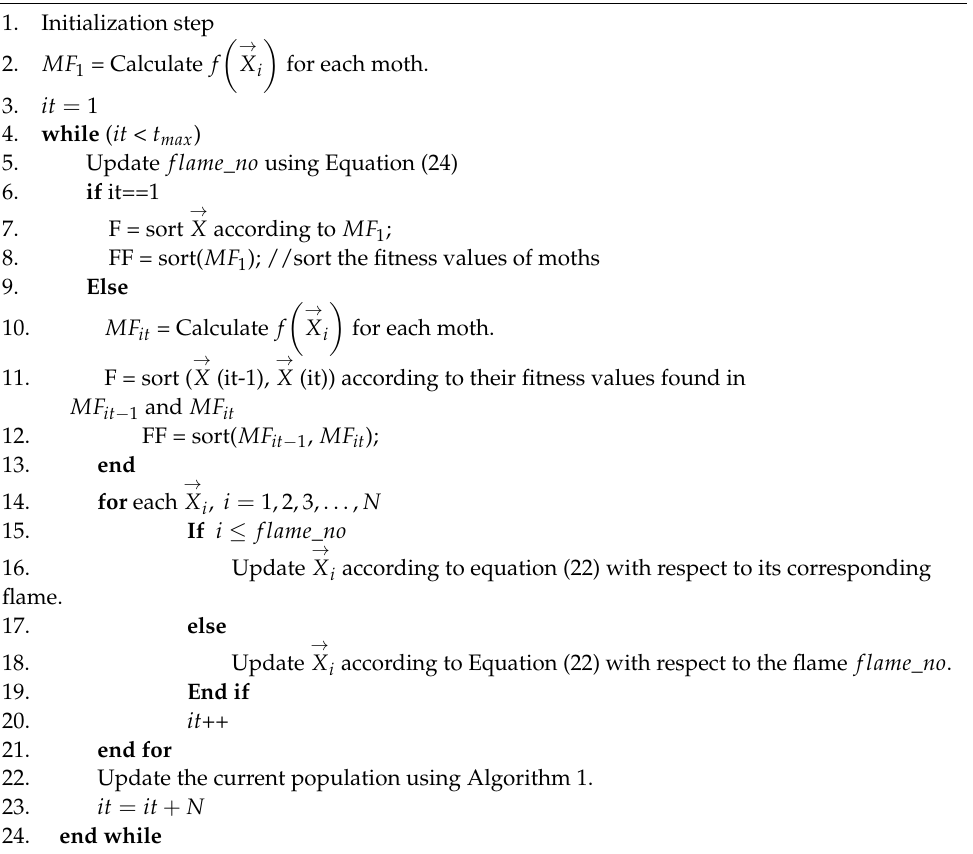
Algorithm 3 The steps of PCM integrated